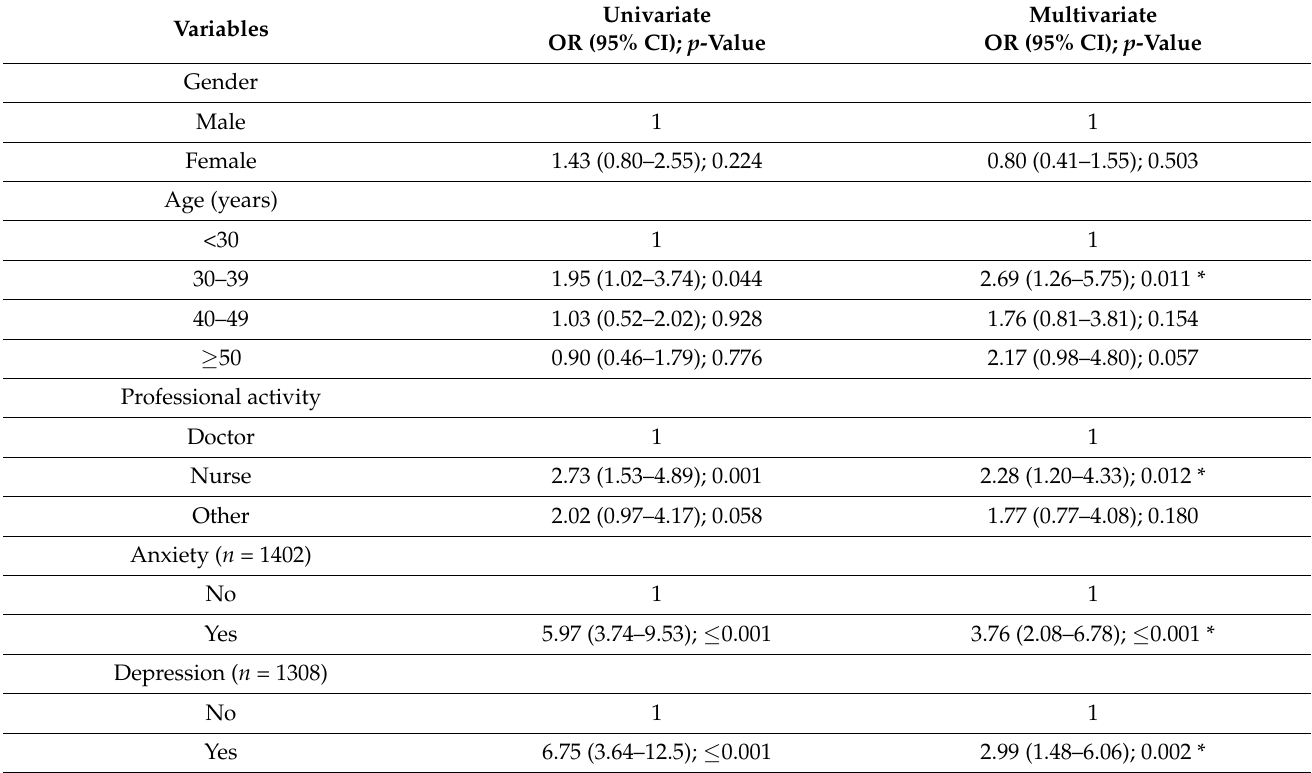
Table 4. Candidates to receive psychological support. Association with sociodemographic, professional, and psychological